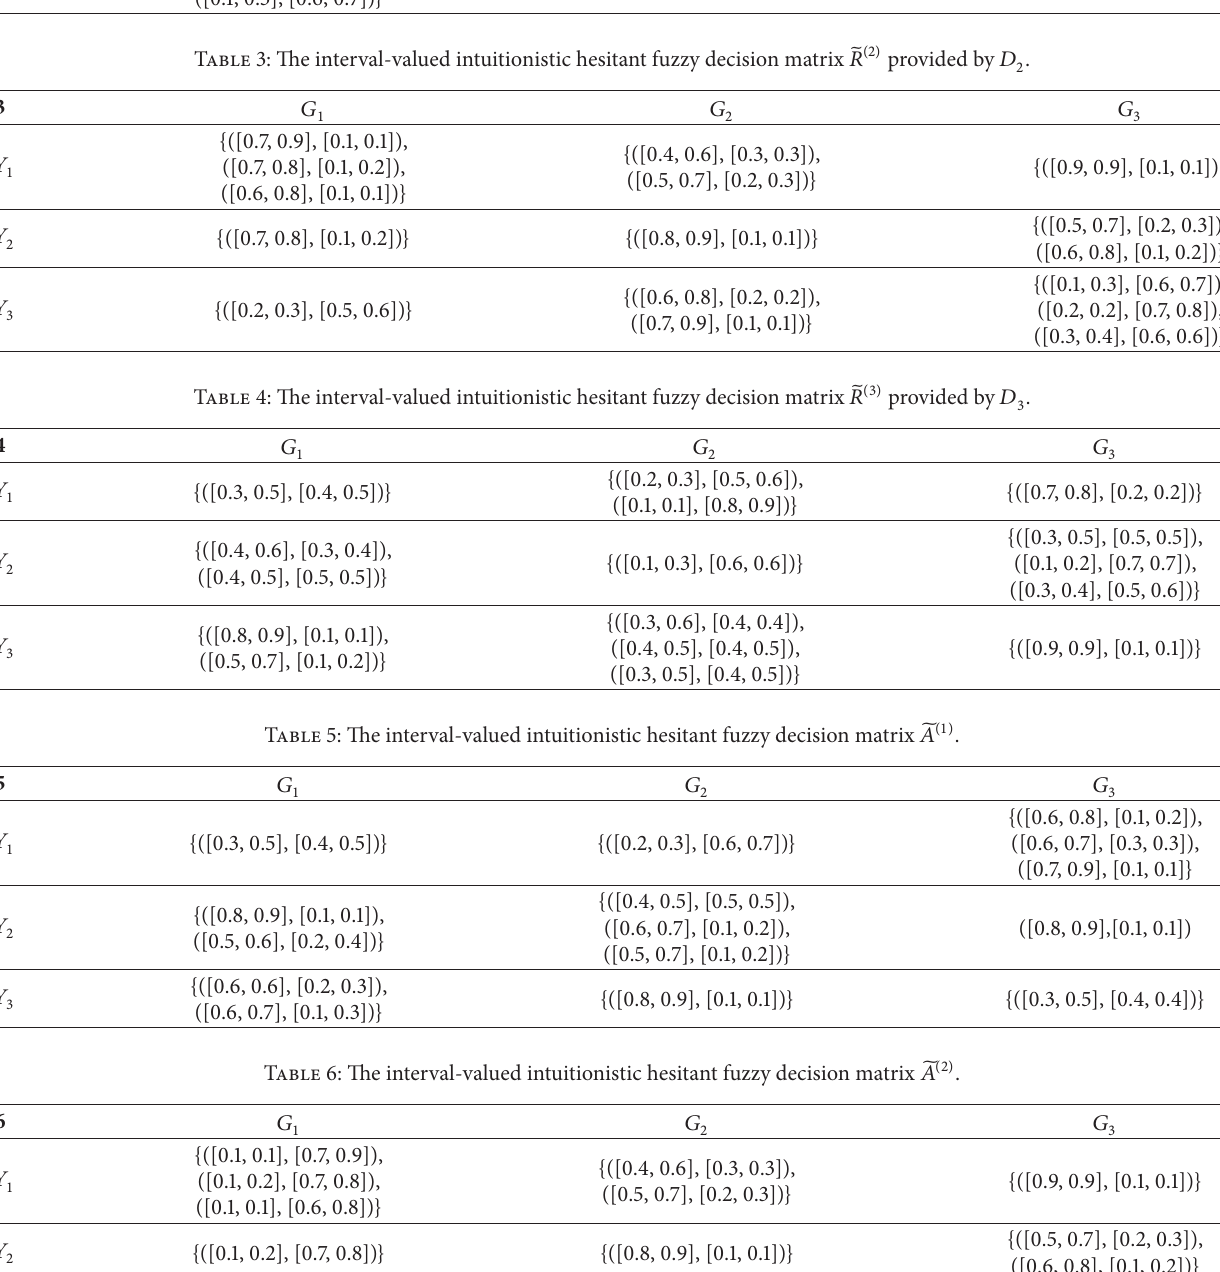
Table 3: The interval-valued intuitionistic hesitant fuzzy decision matrix